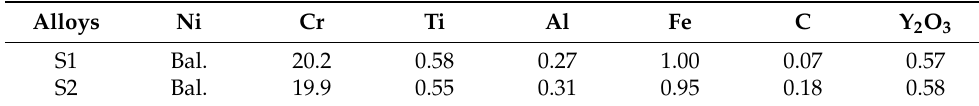
Table 1. Chemical composition of the nickel-based ODS alloy